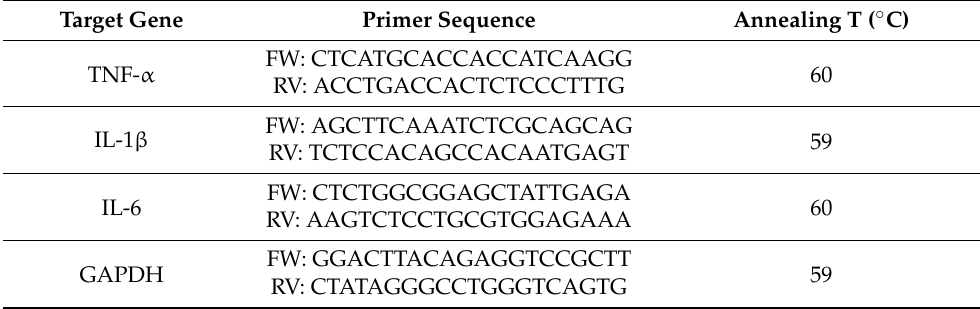
Table 1. Sequences of PCR primers used for qRT-PCR.